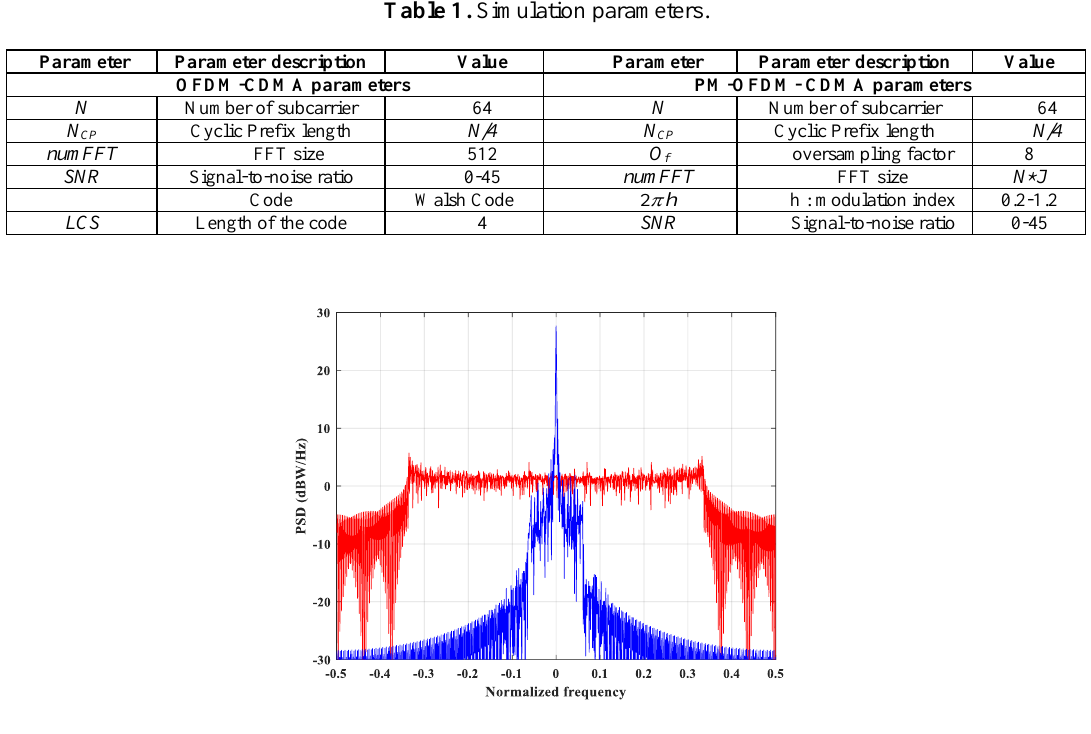
Figure 6. PSD for PM-OFDM-CDMA compared to OFDM-CDMA